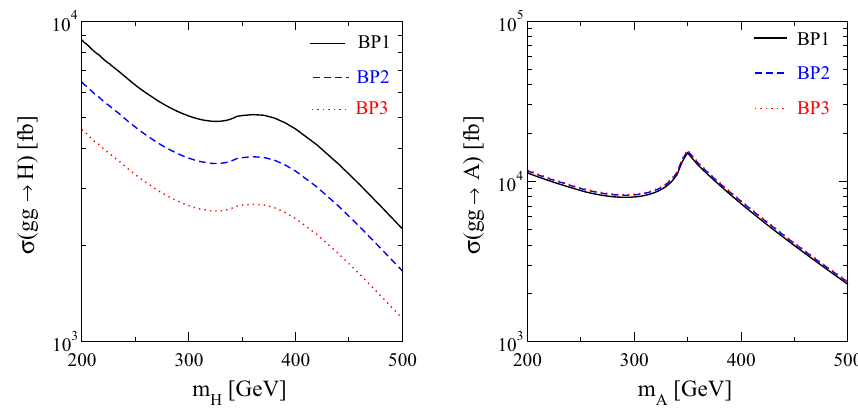
Fig. 8 Cross section of the gluon-fusion process for H ( left ) and A ( right ) as a function of the extra neutral Higgs boson √ s = 13TeV in BP1, mass at BP2 and BP3 with tan β =